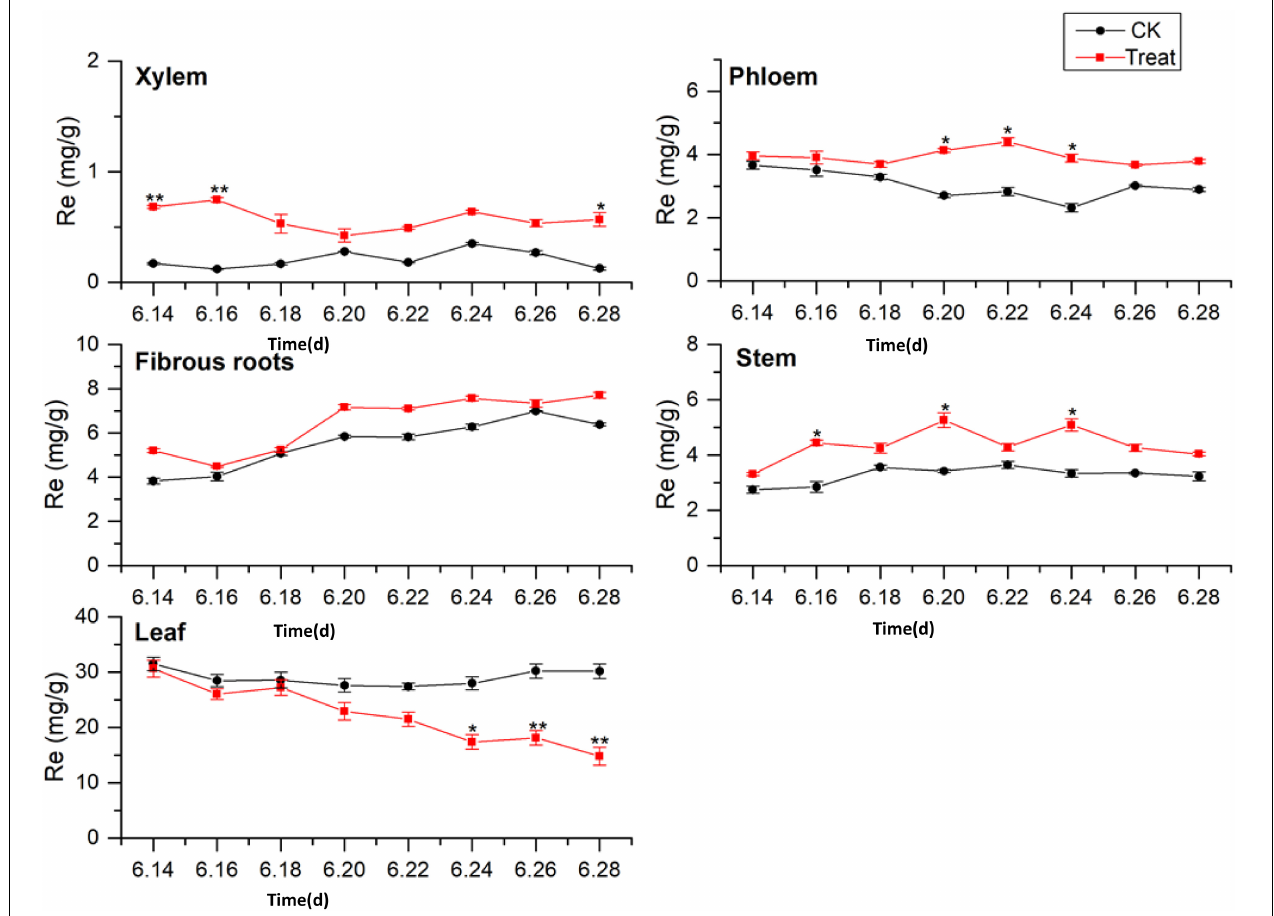
FIGURE 5 | Effects of cold stress on Re in different tissues of flowering ginseng. The X axis represents the sampling time. * p < 0.05 and ** p < 0.01, compared with control group. The data are expressed as the mean ± SD ( n =